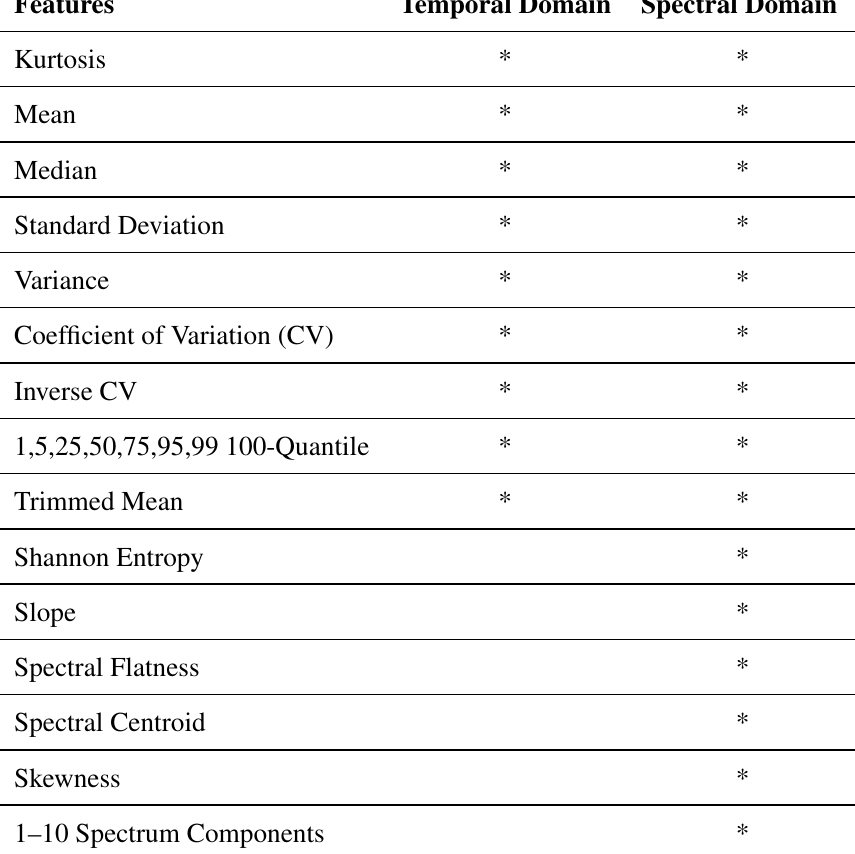
Table 1. Features